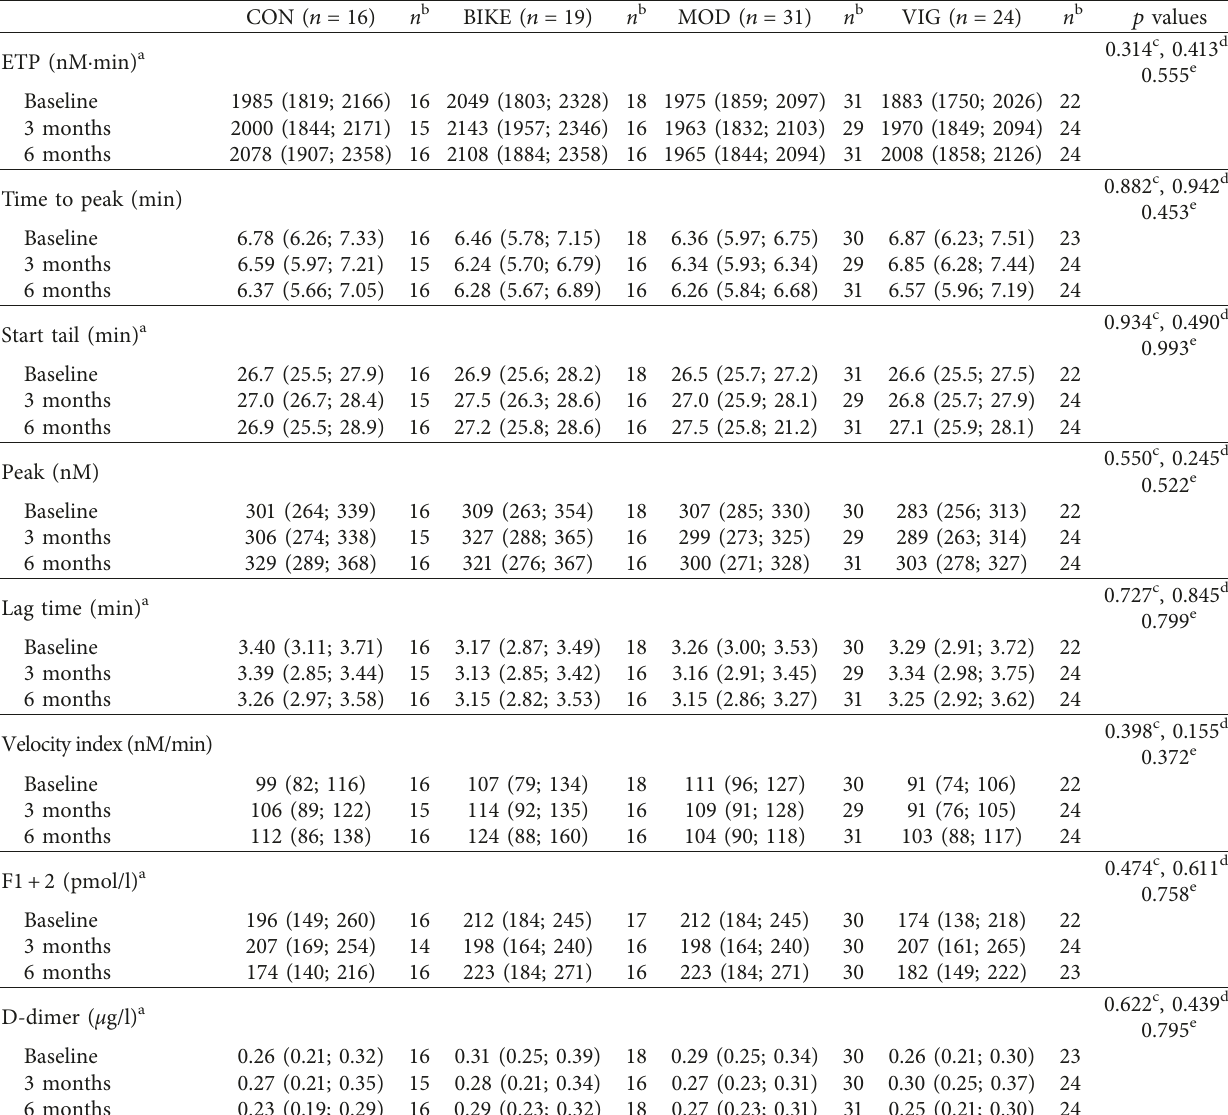
Table 3: Biomarkers of coagulation activation at baseline and at 3 and 6